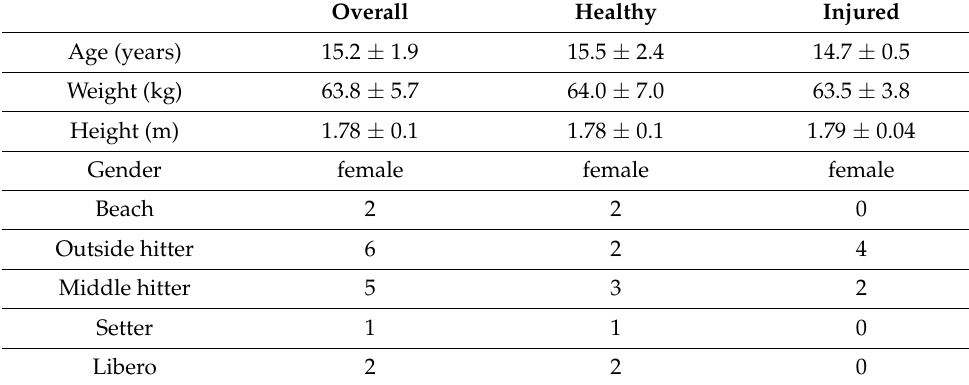
Table 1. Subject characteristics such as age, weight, and height of the healthy and injured groups are expressed in means and standard deviations. Specialization in regard to sports activity type (indoor versus beach) and playing position is expressed in categorical variables for “overall” and in percentages for “healthy” and “injured” in relation to